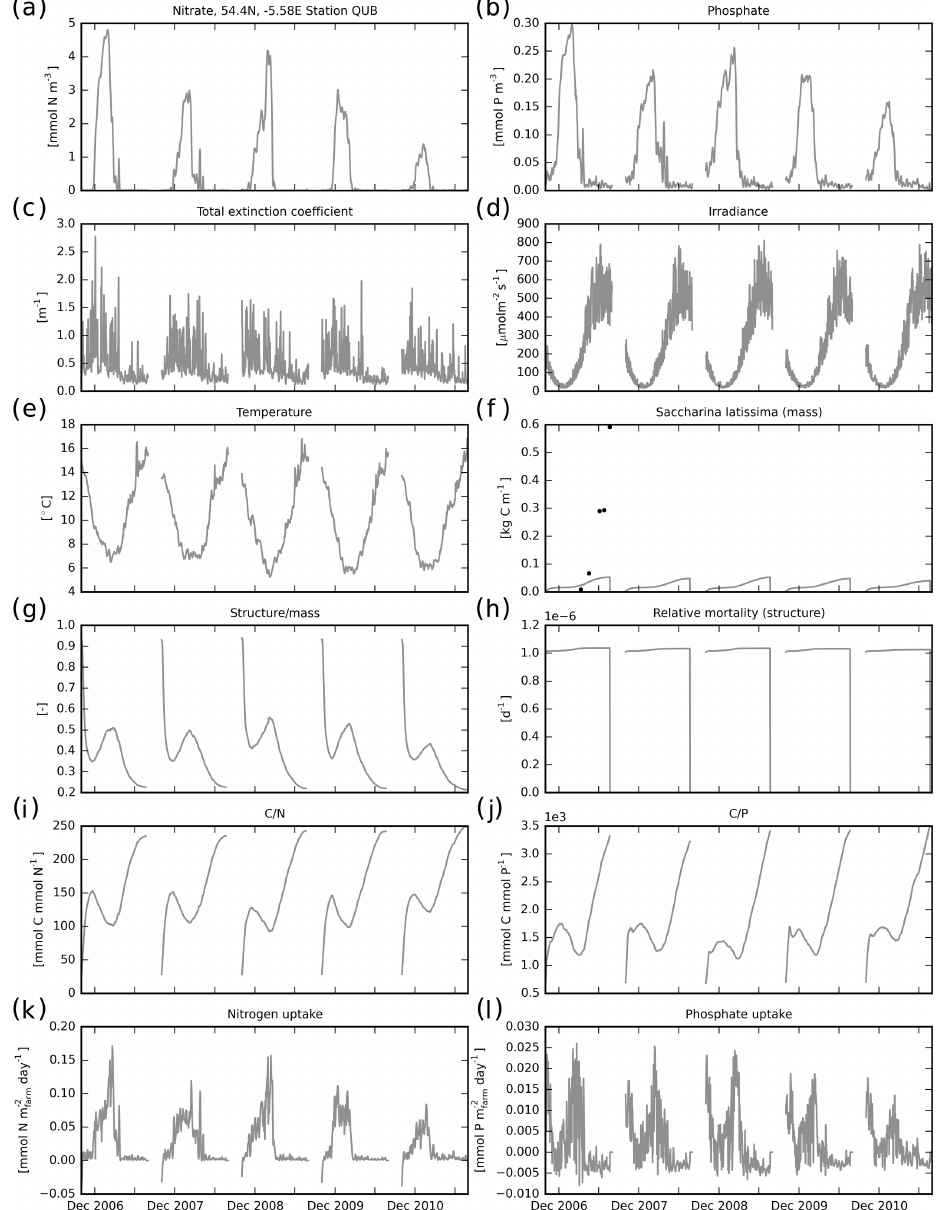
Figure 9. Model results for the Strangford Lough farm site. (a) Surface nitrate concentration; (b) surface phosphate concentration; (c) to- tal extinction coefficient at the surface (excluding contribution by macroalgae); (d) irradiance at the surface; (e) surface water temperature; (f) macroalgae carbon biomass (structure plus carbohydrates) per metre of line; (g) mass of macroalgae structure over total (structure plus car- bohydrates) macroalgae mass ratio; (h) relative mortality of macroalgae structure; (i) C / N ratio of macroalgae; (j) C / P ratio of macroalgae; (k) farm net nitrogen uptake; (l) farm net phosphate uptake. Black dots in panel (f) are observations from the 2012–2013